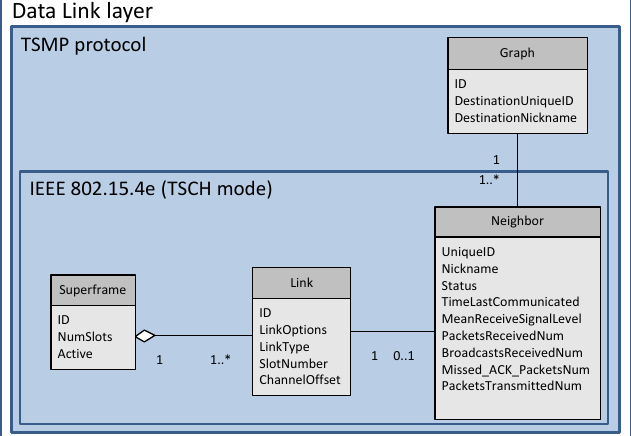
 Graph table : In a graph table, each graph represents the list of potential next-hop neighbors that the data can be forwarded to. This table, in collaboration with the route table located in the upper layer, provides sufficient information for routing the packets. TSCH does not address routing issues, but leaves this to the upper layer. Therefore, the graph table is excluded from D-MSR stack protocol.